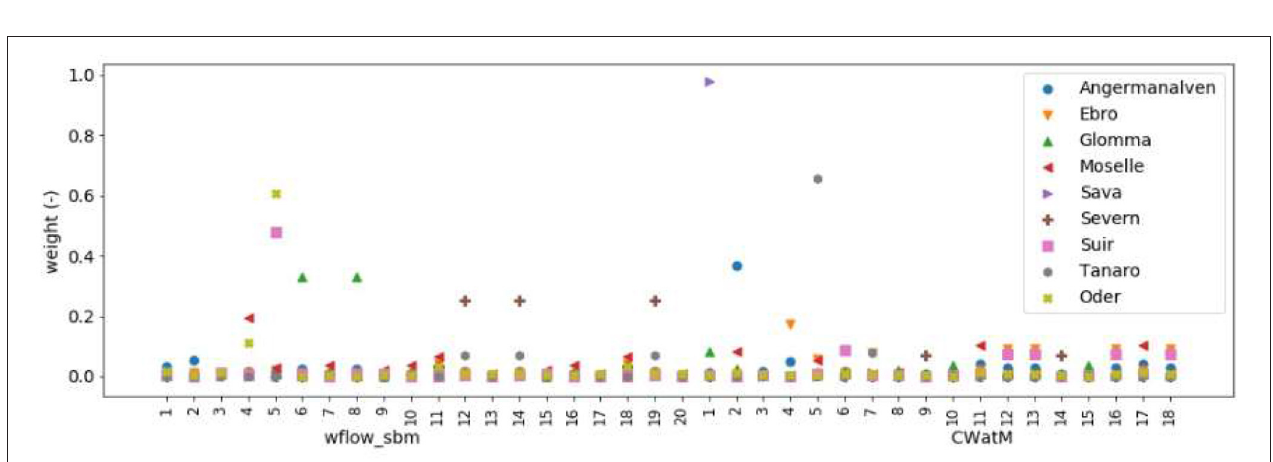
FIGURE 5 | Weights calculated for the individual hydrological model-GCM-RCM combinations for the nine river basins (see legend). The numbers on the x-axis correspond to the GCM-RCM CORDEX datasets listed in Table 2 . First all combinations for Wflow are given, second all combiations for CWatM. The sum off all weights for one river including both CWatM and Wflow simulations adds up to 1.